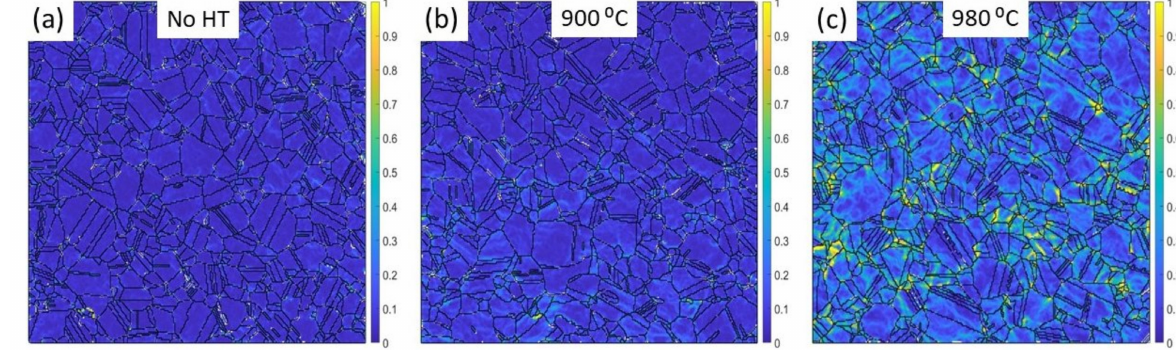
Figure 9. KAM maps for ( a ) no HT, ( b ) 900 ◦ C, and ( c ) 980 ◦ C specimens. KAM increased as the heat treatment temperature increased.